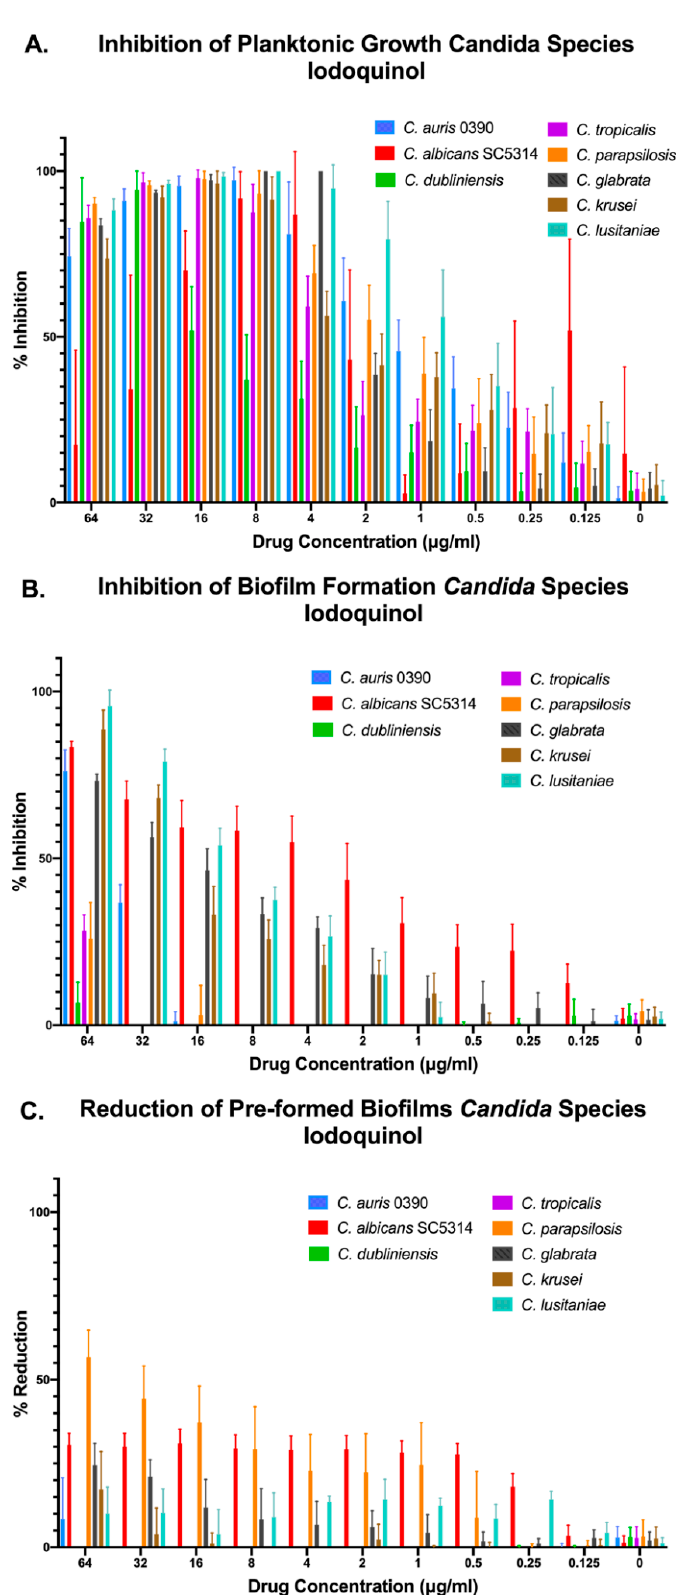
Figure 5. Activity of iodoquinol against representative strains from different Candida spp. under the three different growing conditions: inhibition of planktonic growth ( A ), inhibition of biofilm formation ( B ), and activity against preformed biofilms ( C